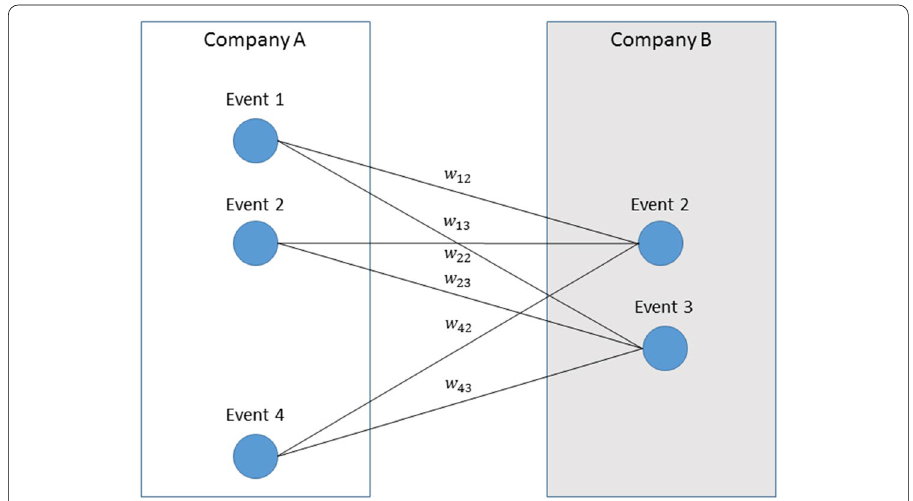
Fig. 4 Example of grouping events to